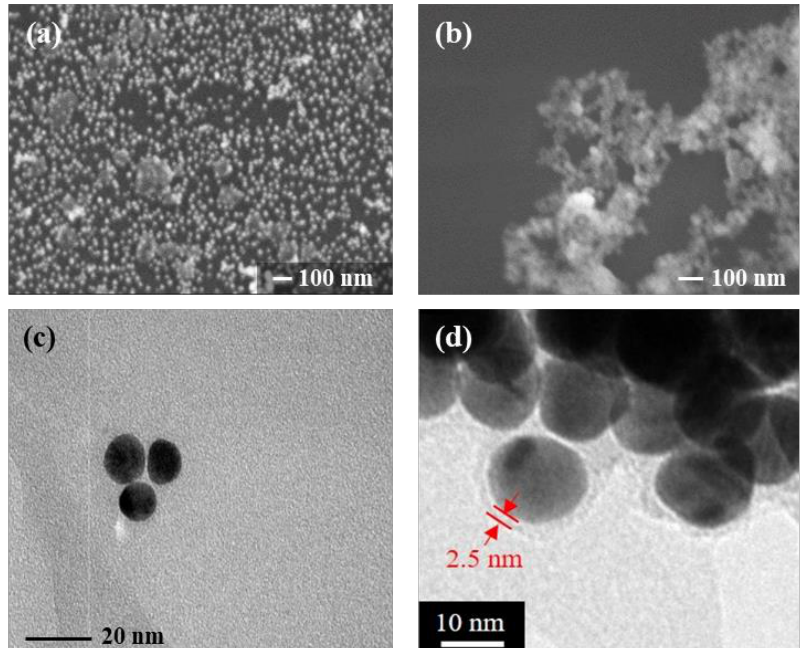
Figure 2. ( a ) Morphology of the Au NPs before modification with MPTMS appeared to be scattered throughout the substrate while ( b ) after grafting the MPTMS onto the surface of the Au NPs, the particles became more agglomerated; ( c ) Au NPs appear to be in a range of 12–20 nm in diameter, with the ( d ) MTPMS layer with 2.5 nm in thickness.